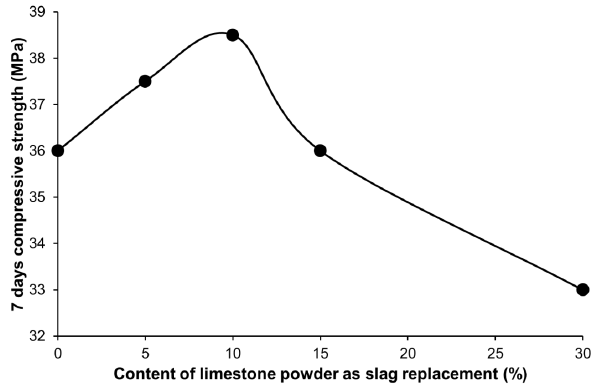
Figure 4: Effect of limestone powder content on 7 days compressive strength (adapted from